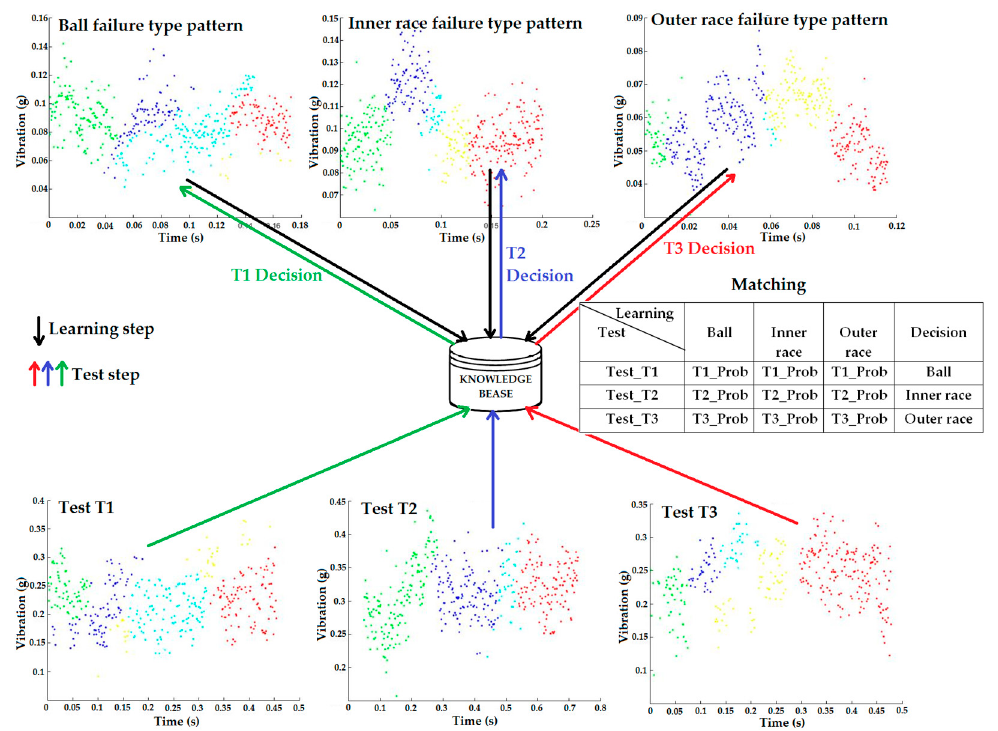
Figure 8. Detection phase illustrative example.